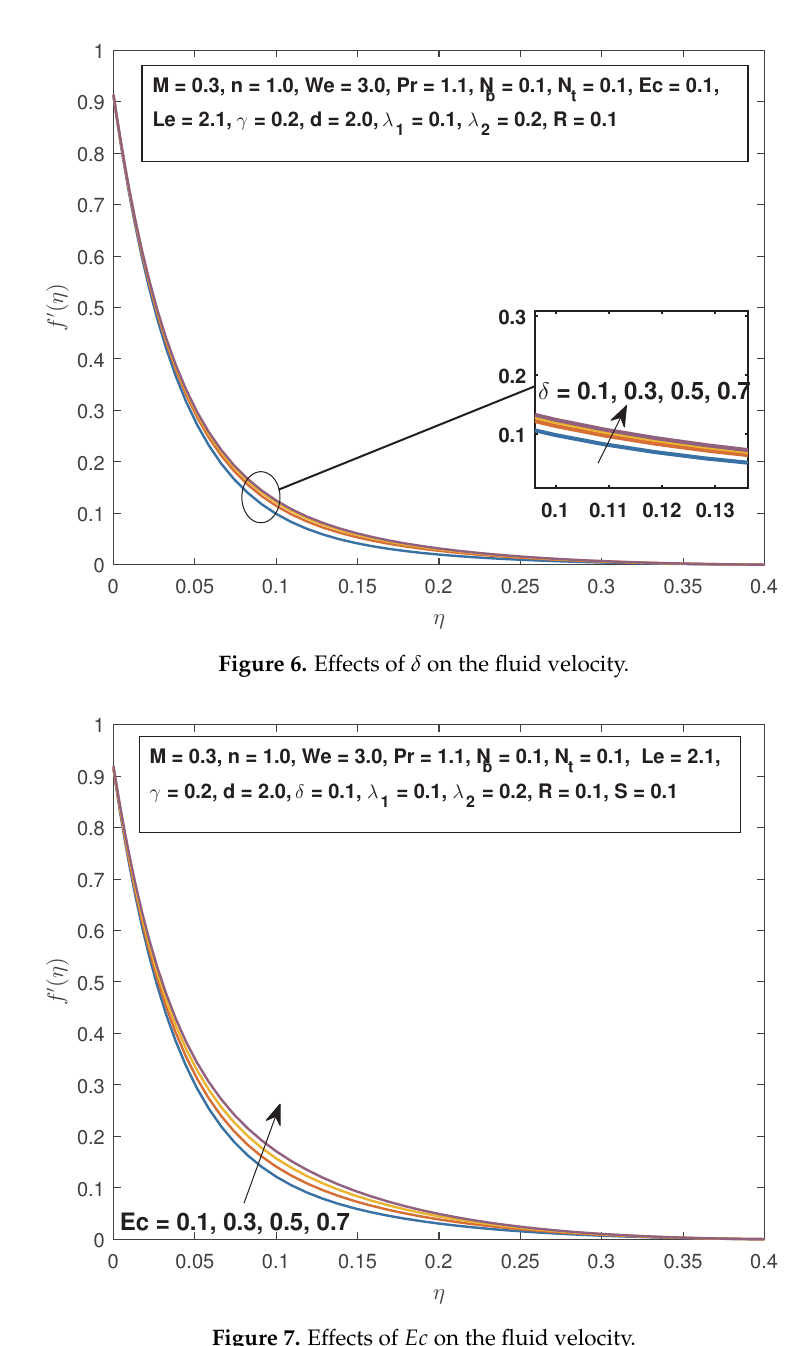
Figure 7. Effects of Ec on the fluid